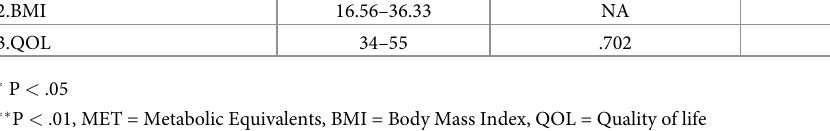
The Table 3, indicates that the proposed fitting indices were relatively weak because of col- linearity. In order to improve the fit of the proposed model, correlation of the residuals was employed. Correlation values greater than 4 were considered to be the correction indicator. The fitting for the suggested pattern was validated by the presented indices. The fitting indices for the final pattern prove that the fitting is valid.